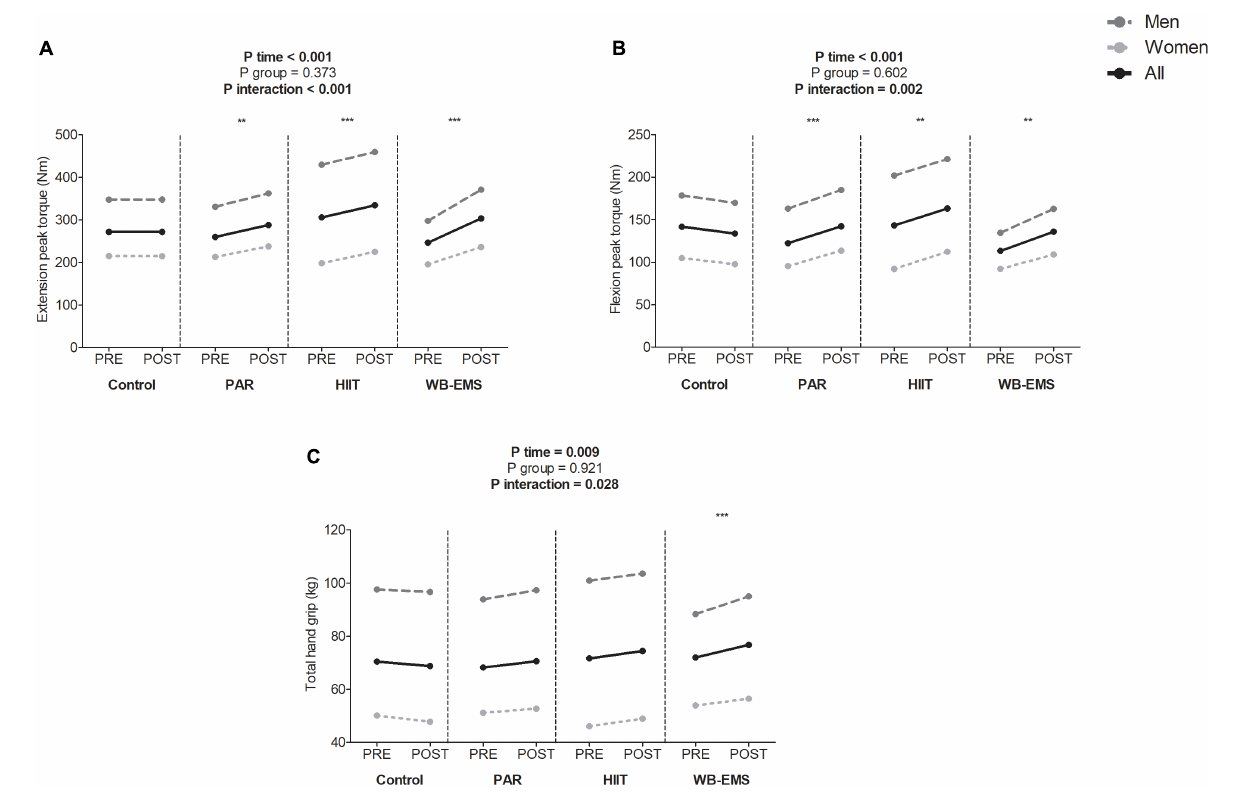
FIGURE 3 | Changes in extension peak torque (A) , flexion peak torque (B) , and total hand grip (C) values before and after the intervention study. P -value [time, group, and interaction (time ∗ group)] of repeated measures analysis of variance. ∗ P < 0.05, ∗∗ P < 0.01, ∗∗∗ P < 0.001 obtained by Student’s paired t -test. PAR, physical activity recommendations for adults proposed by the World Health Organization group; HIIT, high intensity interval training group; WB-EMS, whole-body electromyostimulation